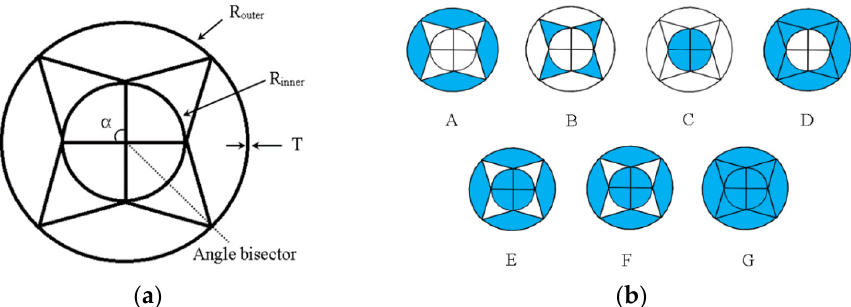
Figure 1. Geometric configuration of the filling structure: ( a ) novel thin-walled structure; ( b ) filling styles.